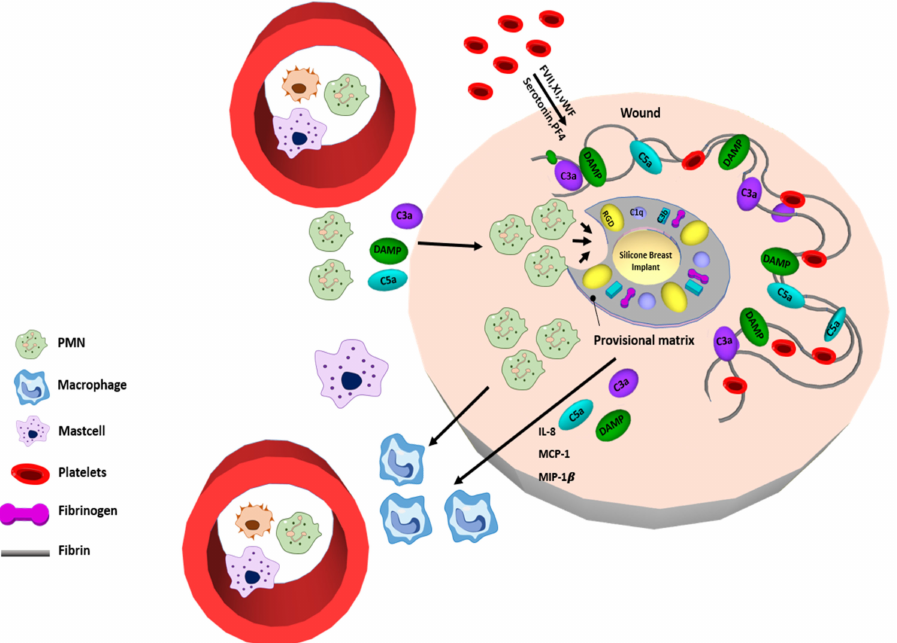
Figure 2. Schematic illustration of Phase 2 after implantation. Acute inflammatory stage with avail- ability of polymorph nuclear leukocytes (PMN, neutrophils), mast cell and presence of macrophages at the implantation site. Coagulation factor and fibrin infiltrated at the implant site. Reproduced with permission from